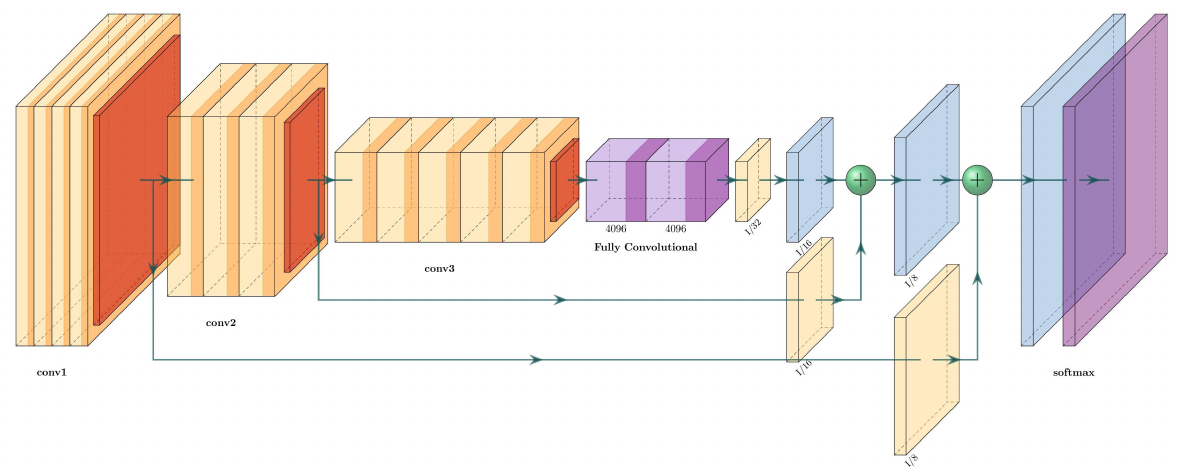
Figure 6. Architecture of the FCN-8 of a generic DNN.